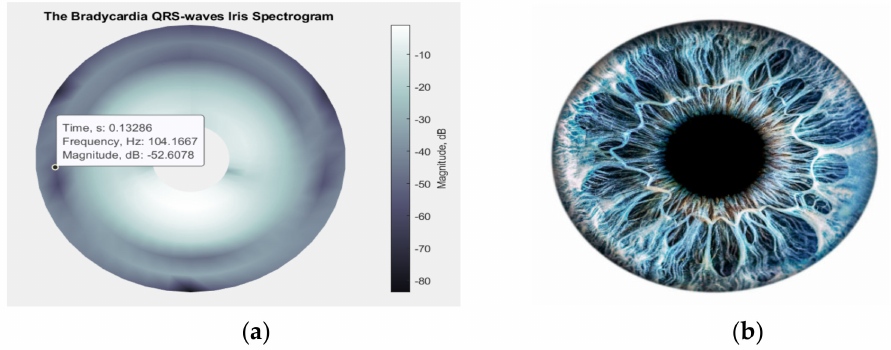
Figure 6. ( a ) An irisgram of QRS-waves; ( b ) Human eye